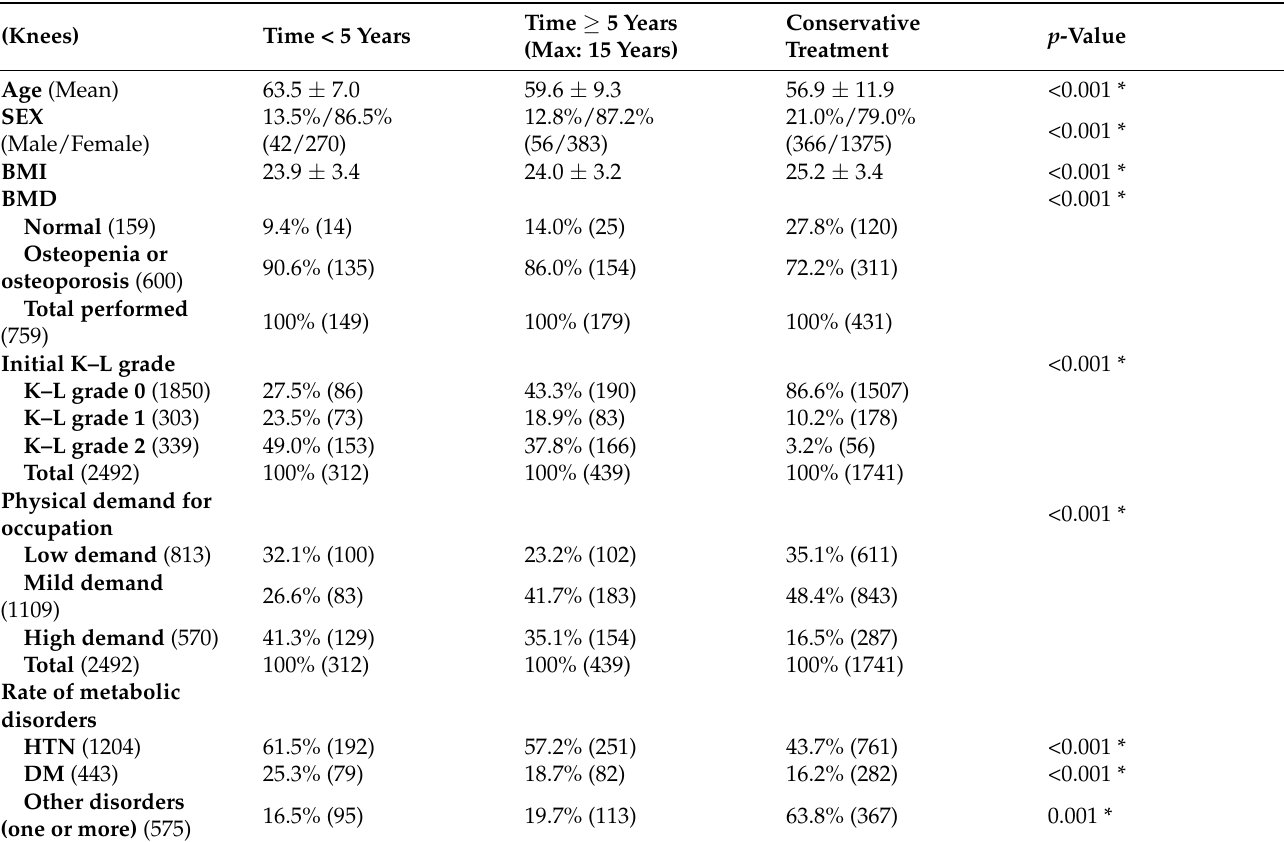
Table 3. Comparison of affecting factors according to the fate of